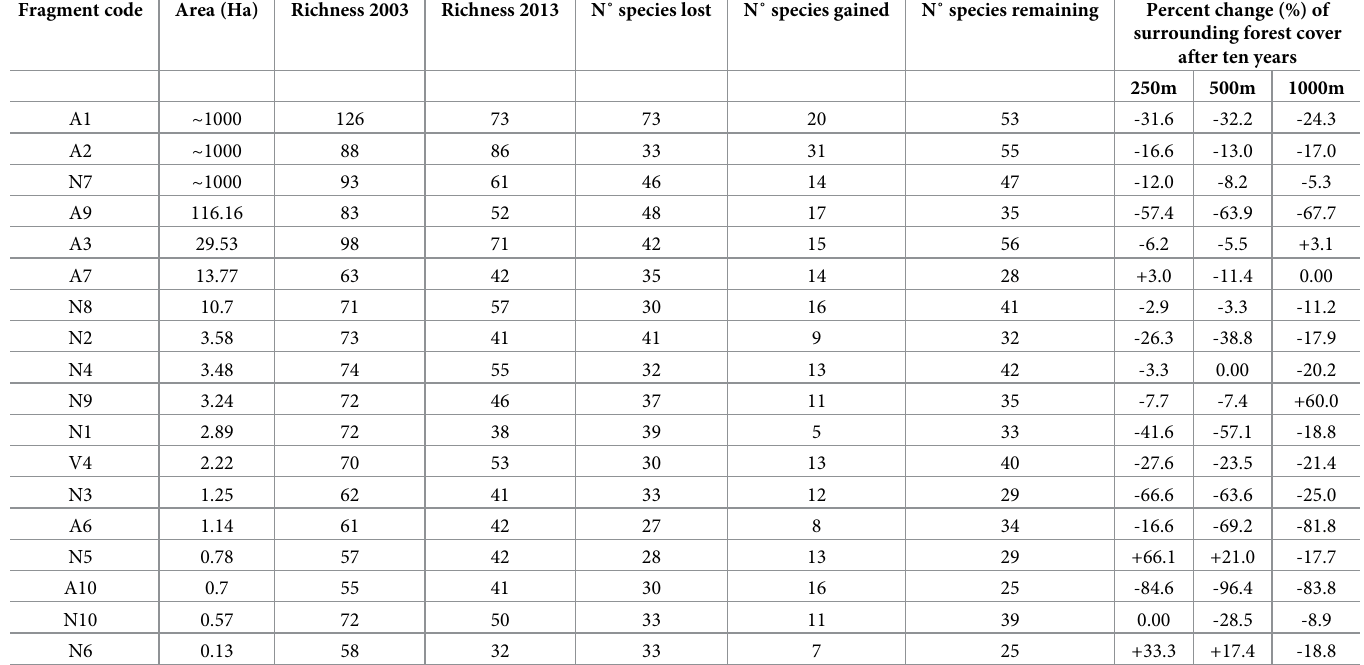
Table 1. Balance of plant species richness after a decade. Species richness of sampled Chaco Serrano forest fragments in 2003 and 2013. The number of lost, gained, and remaining species per forest fragments after a decade were calculated from a species presence-absence